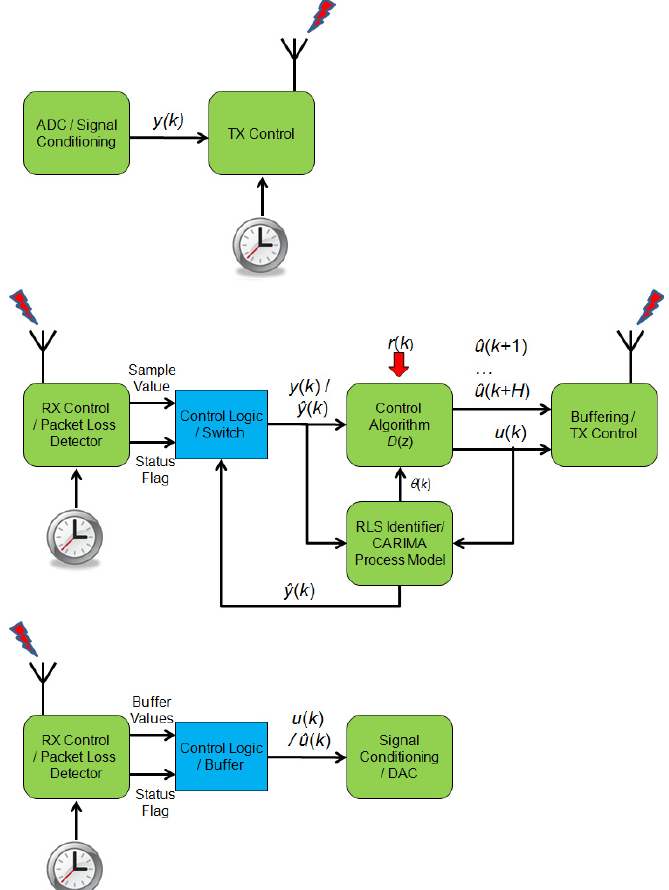
Figure 3. End-to-end elements of the proposed compensation technique (top: sensor node, middle: controller node, bottom: actuator